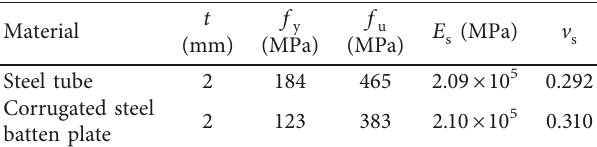
Table 1: Properties of